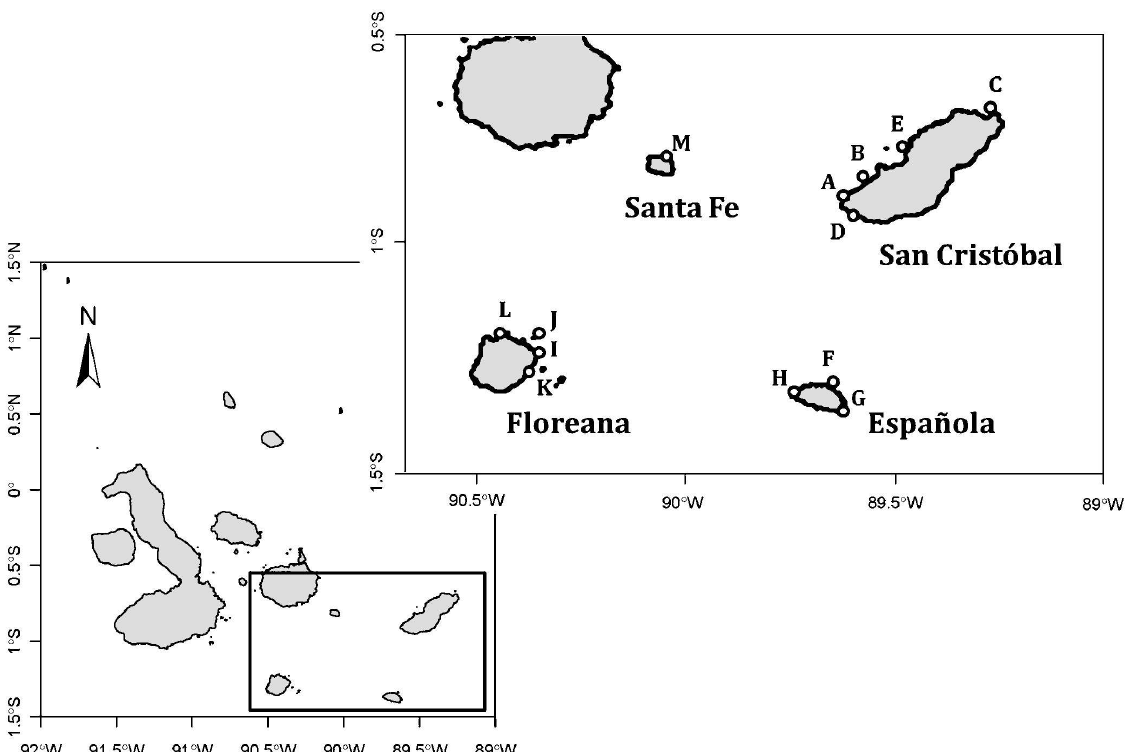
Fig 1. Map of the GalapagosArchipelago showingthe breedingrookerieson four islandsin the southeastern regioncensused duringthe study: San Cristo´bal Island: A) El Maleco´n, B) Isla Lobos, C) Punta Pitt, D) La Loberı´a, E) Cerro Brujo. Espa ñ olaIsland: F) Bahı´a Gardner, G) Punta Sua´rez, H) Punta Ceballos.FloreanaIsland: I) Post Office, J) Champion,K) Las Cuevas, L) Puerto. Santa Fe Island: M) Bahı´a Santa